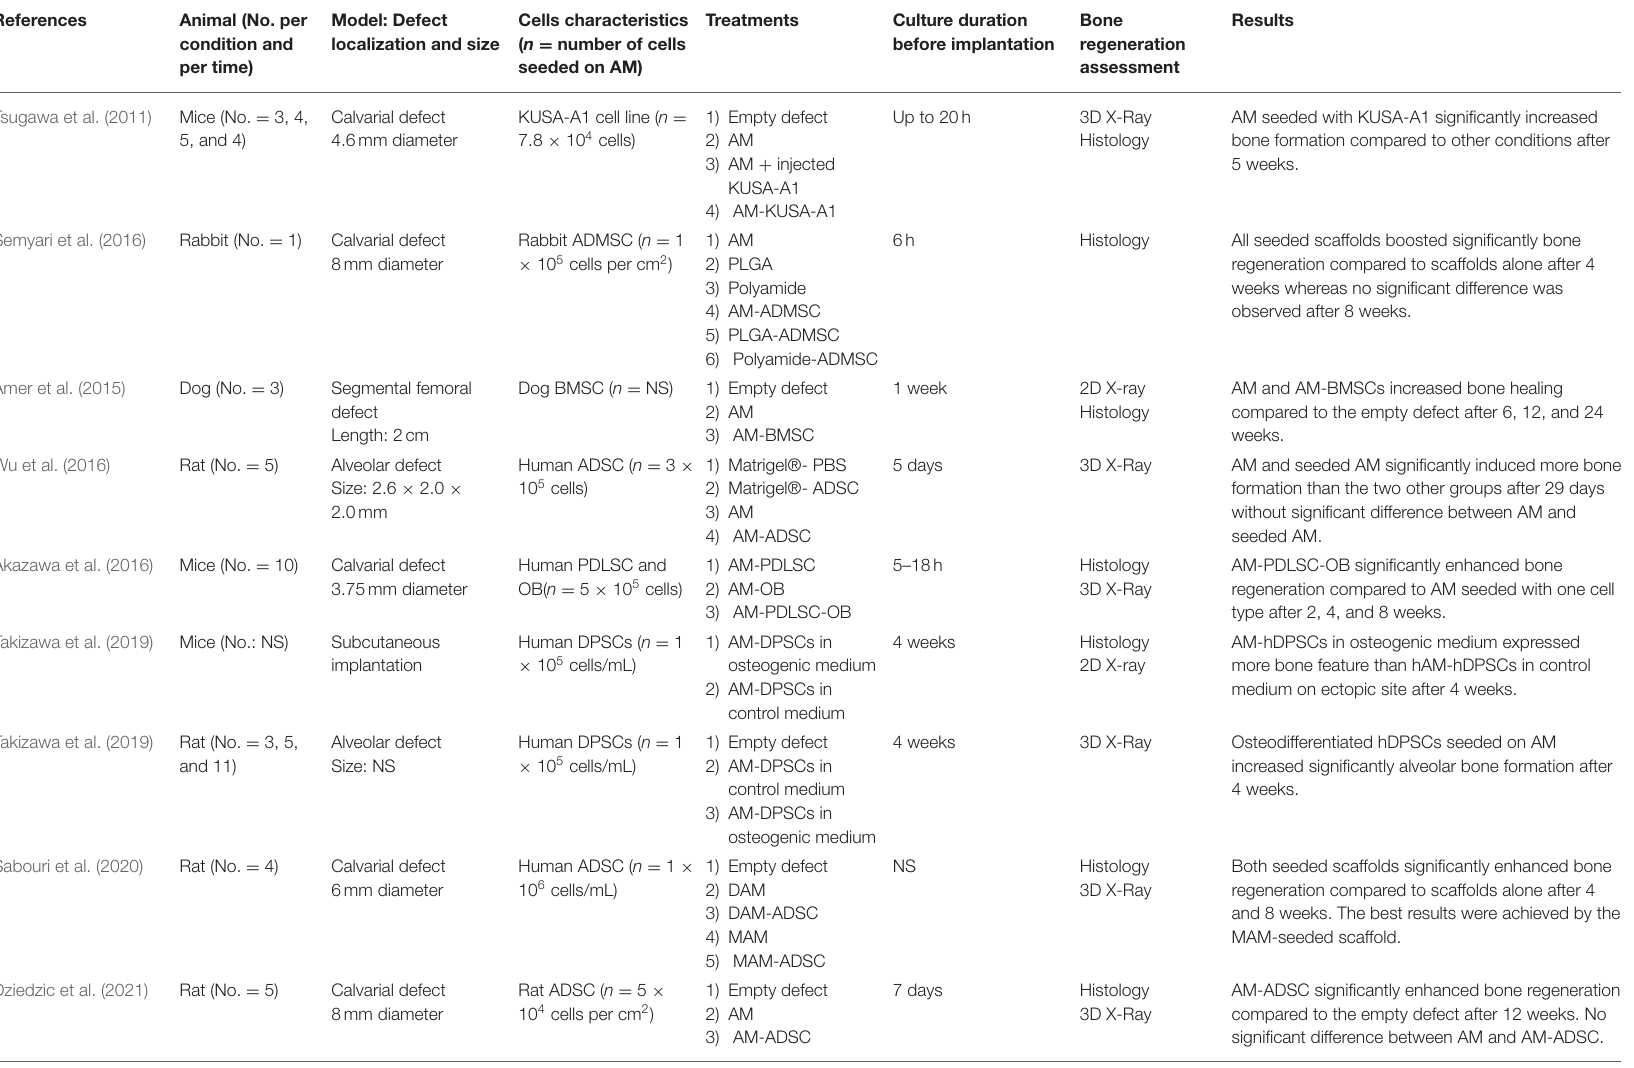
TABLE 3 | Pre-clinical studies using AM seeded with stromal cells to promote bone